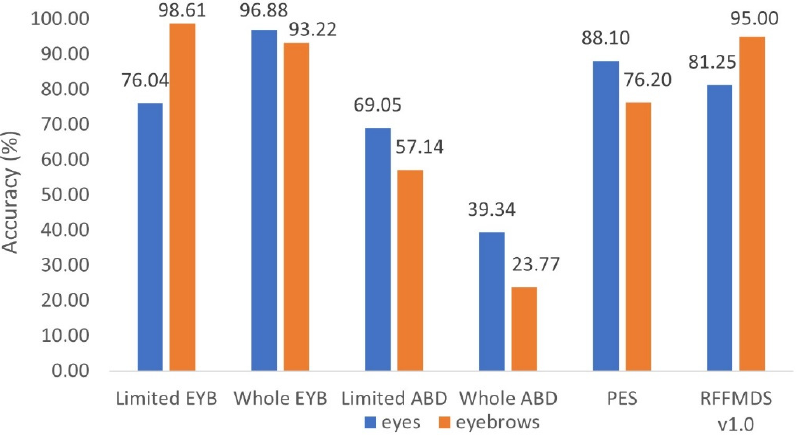
Figure 9. Accuracy results (%) from EYB, ABD, PES, and RFFMDS v1.0 datasets for eye images and eyebrow images.